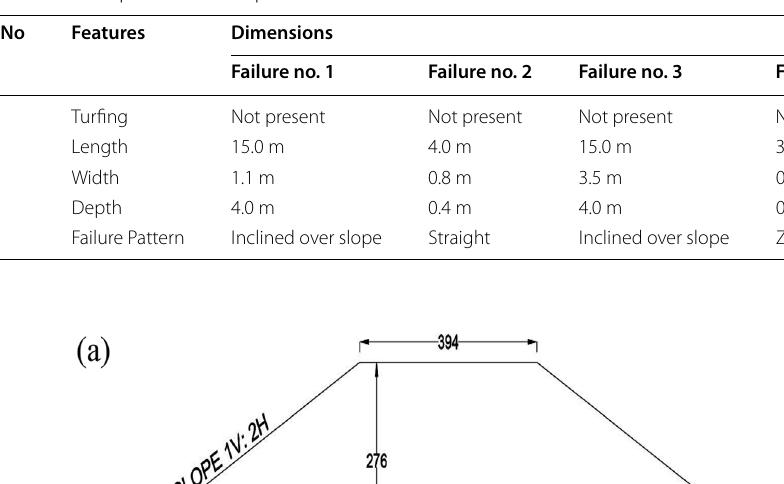
Table 3 Description of failure patterns